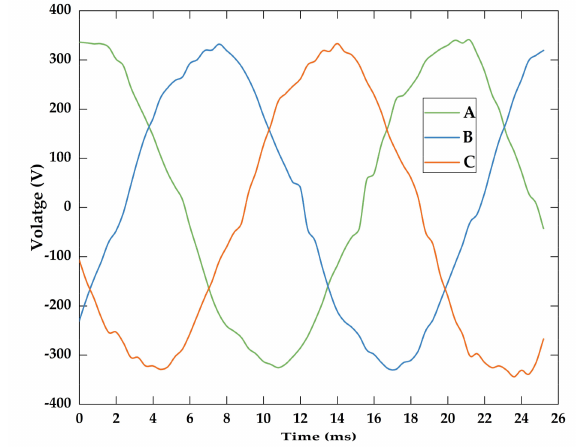
Figure 8. Voltages of DC/AC inverter of three-port